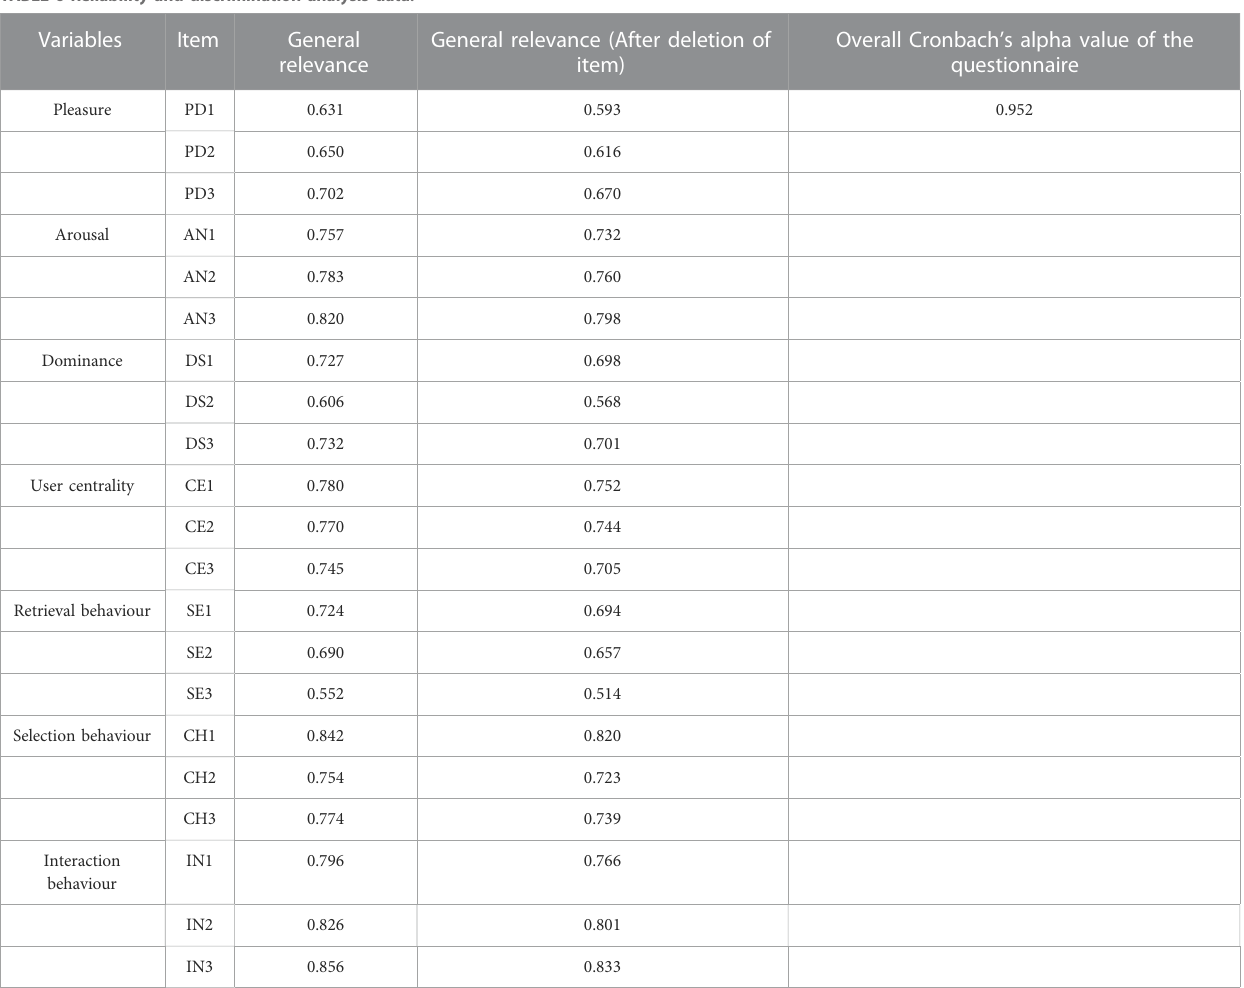
TABLE 6 Reliability and discrimination analysis